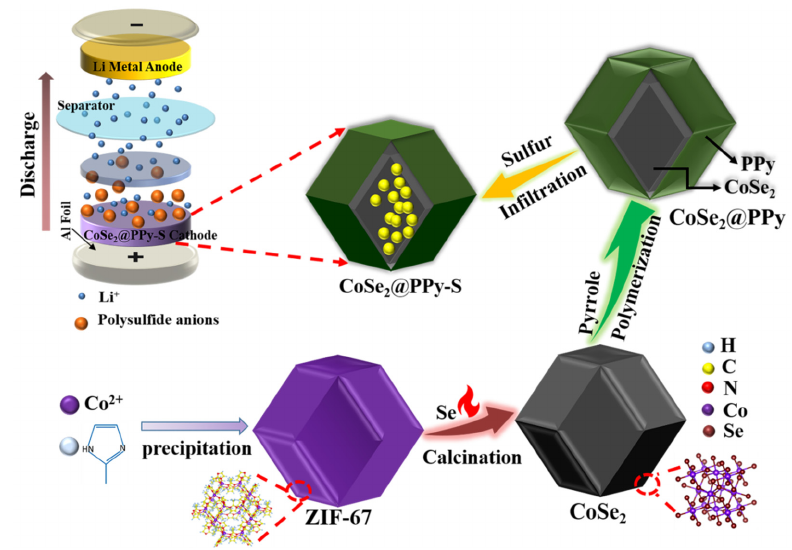
Figure 1. Flow chart of the preparation of CoSe 2 @PPy-S composites.